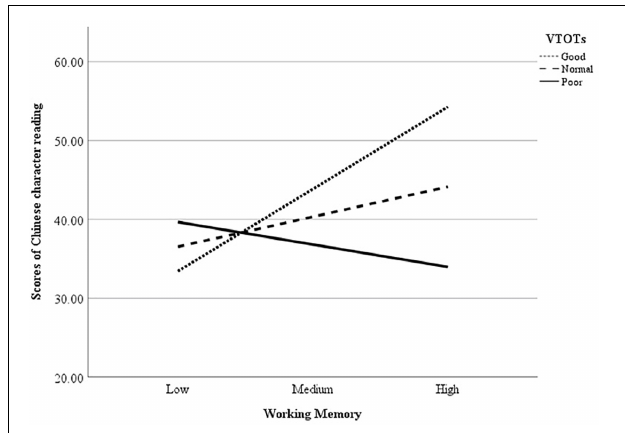
FIGURE 2 | The relationships between working memory and Chinese character reading of children with different levels of VTOTs. VTOTs, visual temporal order